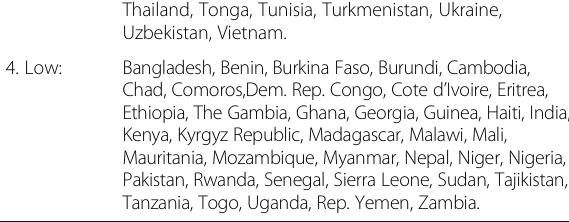
Table 11 Fully modified ordinary least squares test (Pre GFC, Year = 1995 to 2008) Income